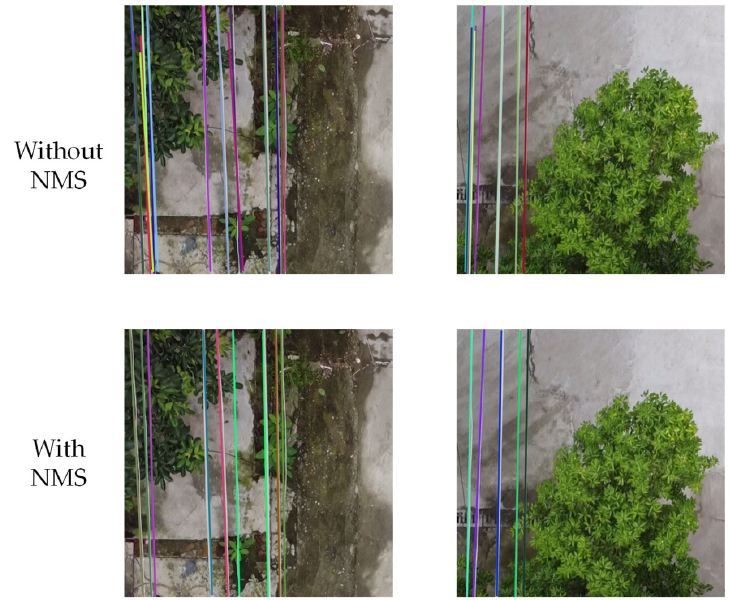
Figure 12. Comparison of the result before and after NMS.